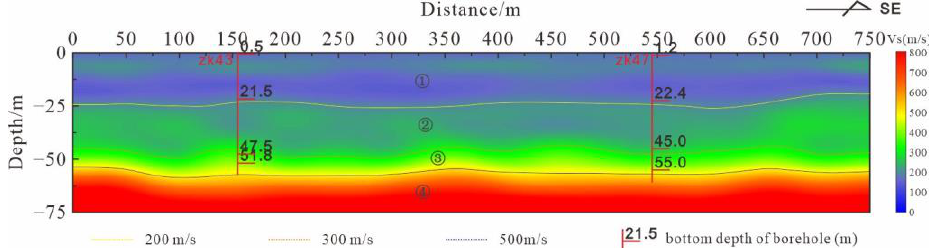
Figure 8. Microtremor inversion result of the He ’ an line in area I.